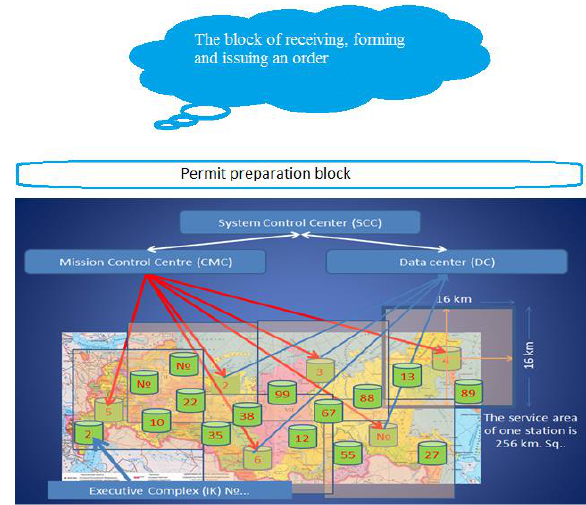
Figure 1. Structure of the AIGS system